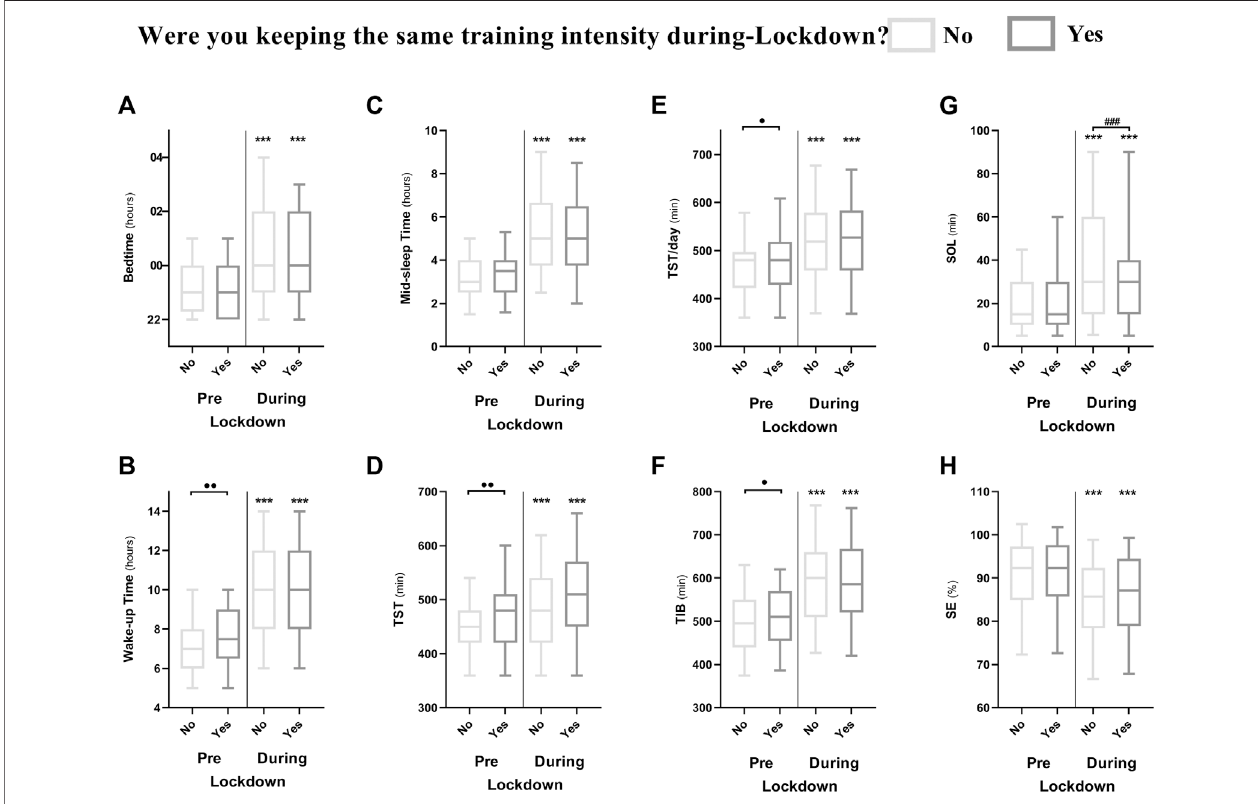
FIGURE4| Differencebetweenathleteswhowerekeepingthesametrainingintensityduring-comparedtopre-lockdown( n =351;Yes)andthosewhowerenot( n = 1,025; No) in different sleep metrics; (A) Bedtime; (B) wake time; (C) mid-sleep time; (D) total sleep time; (E) total sleep time per 24 h; (F) time in bed; (G) sleep onset latency and (H) sleep ef fi ciency. *, **and *** means signi fi cant within subject effect of the lockdown at p < 0.05, p < 0.01 and p < 0.001, respectively. · , ·· and ··· means signi fi cant between subject effect pre-lockdown at p < 0.05, p < 0.01 and p < 0.001, respectively. #, ## and ### means signi fi cant between subject effect during- lockdown at p < 0.05, p < 0.01 and p < 0.001, respectively. Signi fi cance is assessed by a mixed design ANOVA and the Bonferroni post-hoc test.